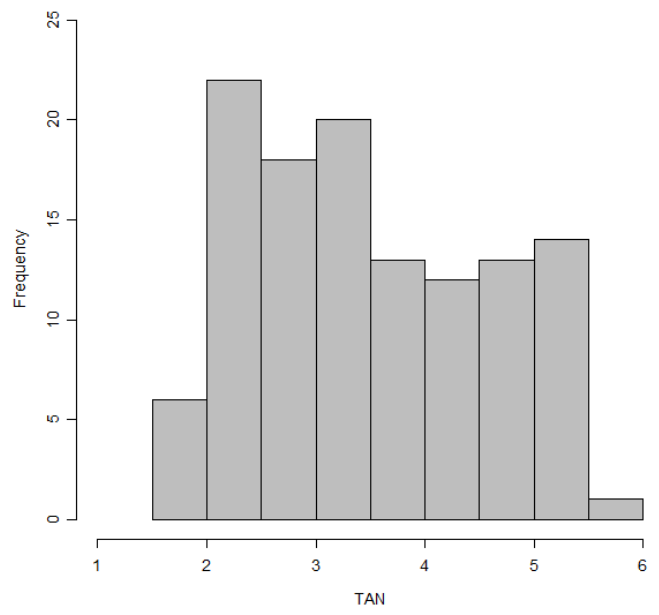
Figure 1. Histogram depicting the spread of the TAN